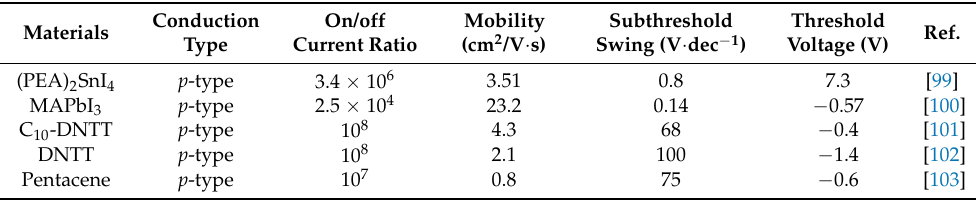
Table 2. The electrical properties of perovskite and organic